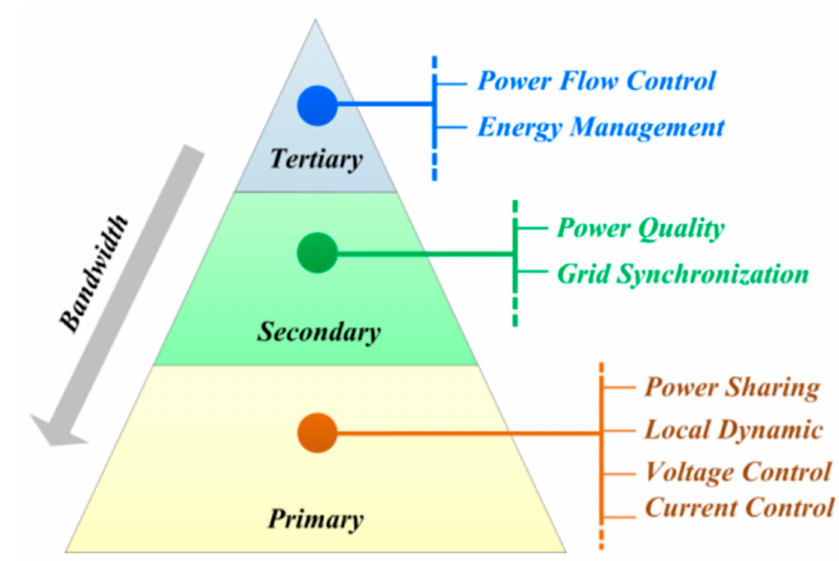
Figure 2. Hierarchy of the microgrid